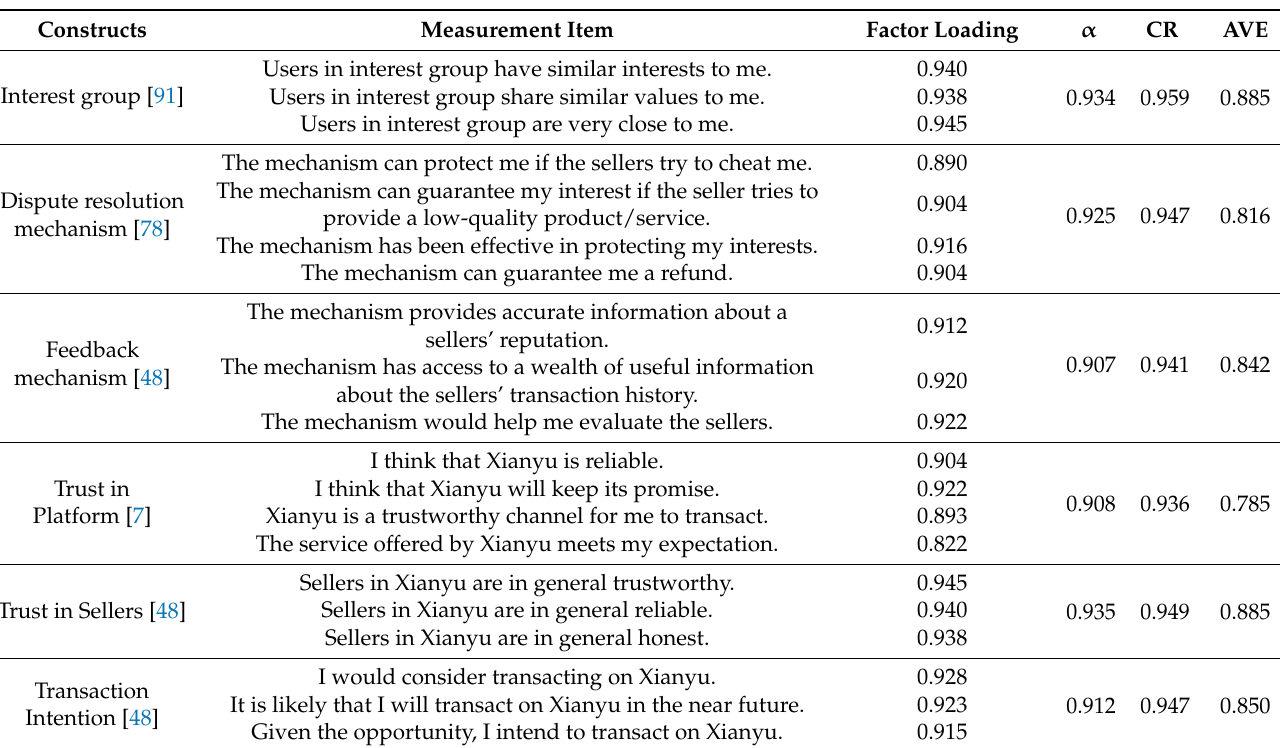
Table 2. Constructs and associated items.